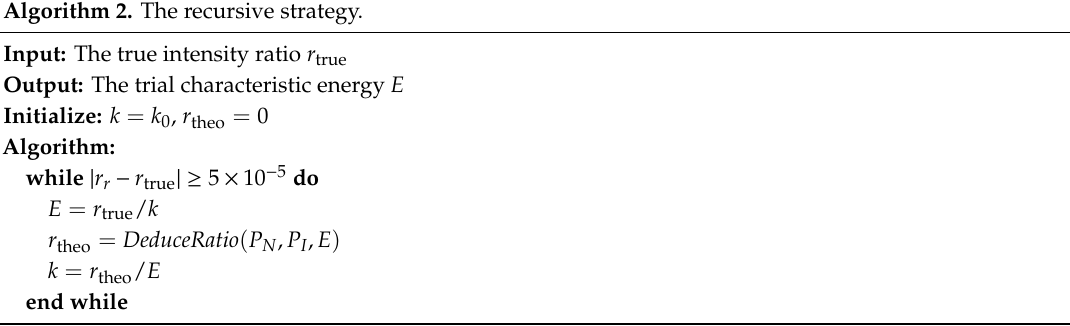
Algorithm 2. The recursive